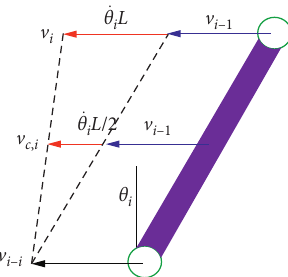
Figure 7: Speed relationship diagram of porcelain